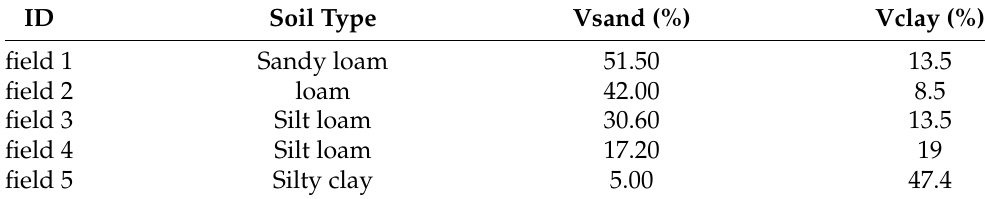
Table 2. Parameter settings for five soil